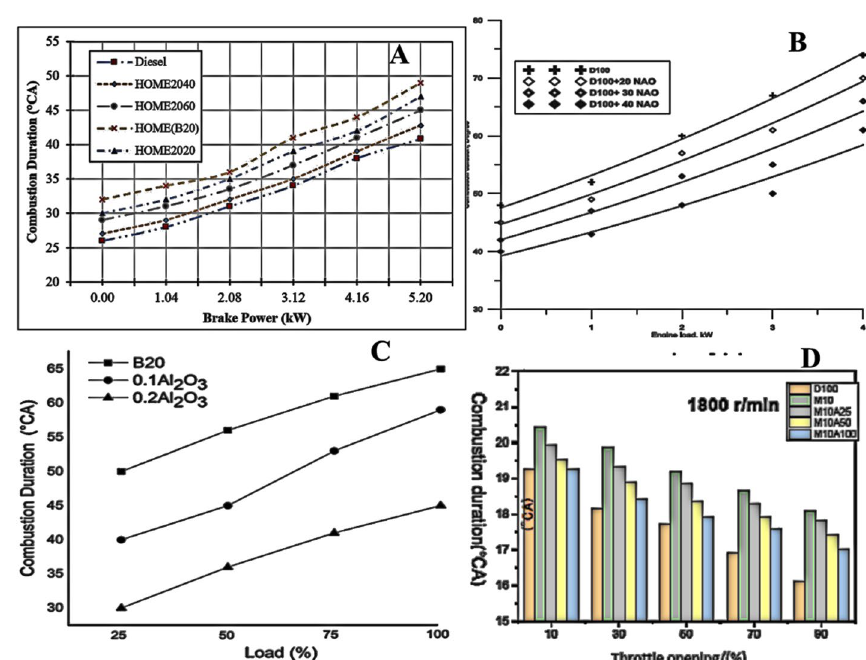
Fig. 13 Effect of combustion duration of nano-added diesel or